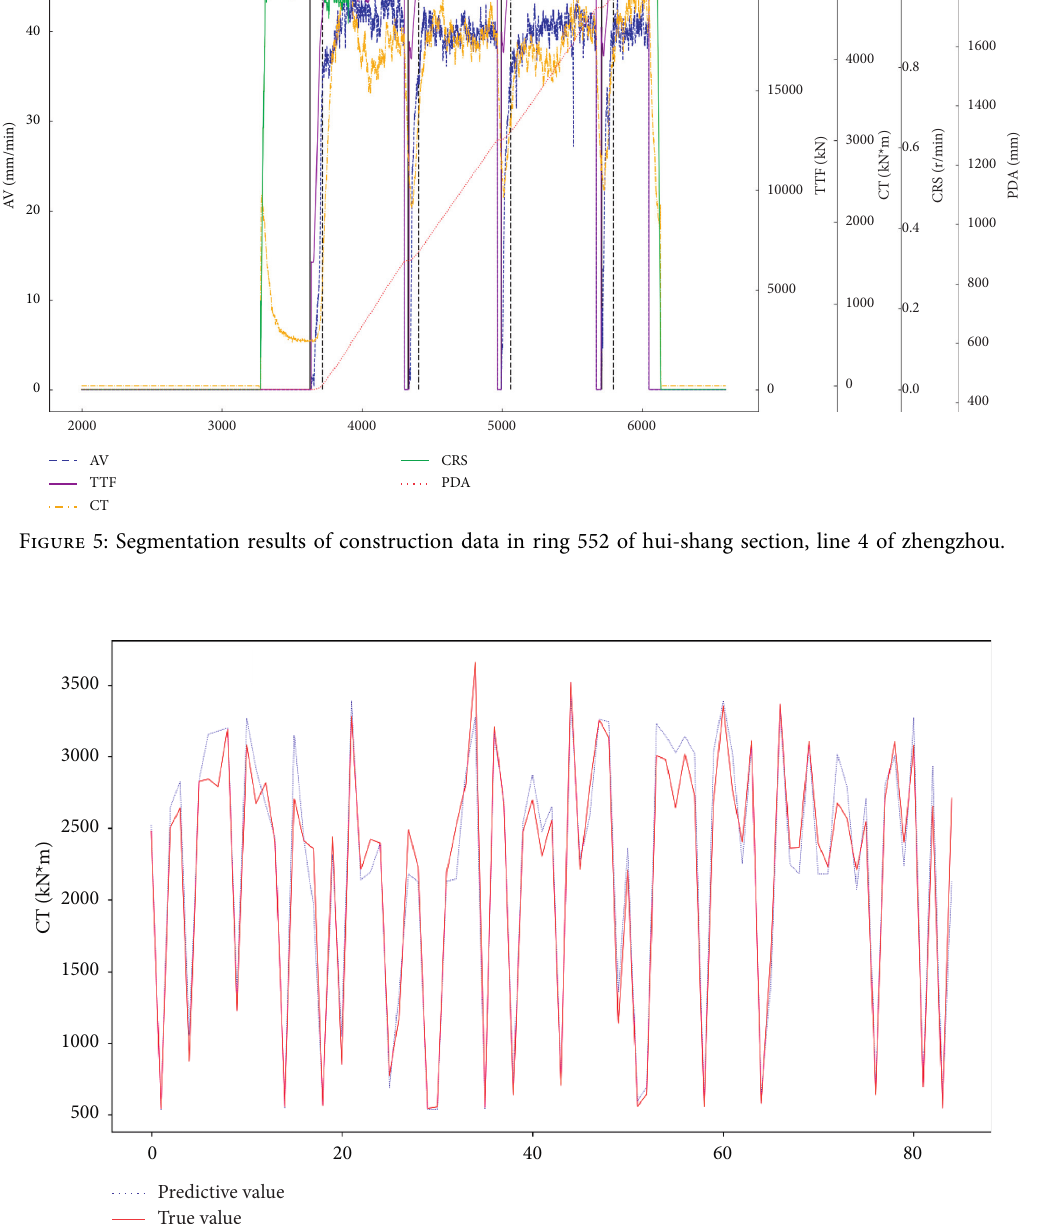
Figure 6: Effect of predicting cutterhead torque by using the linear regression model on the testing